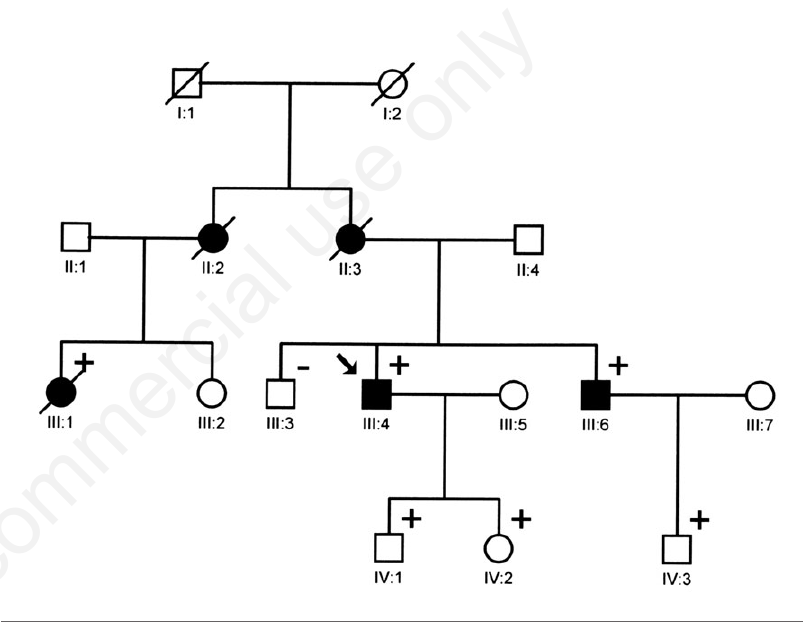
Figure 4. Pedigree of the family affected with the Phe237Ser LMNA mutation. Circles represent women; squares men, black-filled symbols represent clinically affected; plus sign, presence of the Phe237Ser LMNA mutation; minus sign, absence of the mutation.